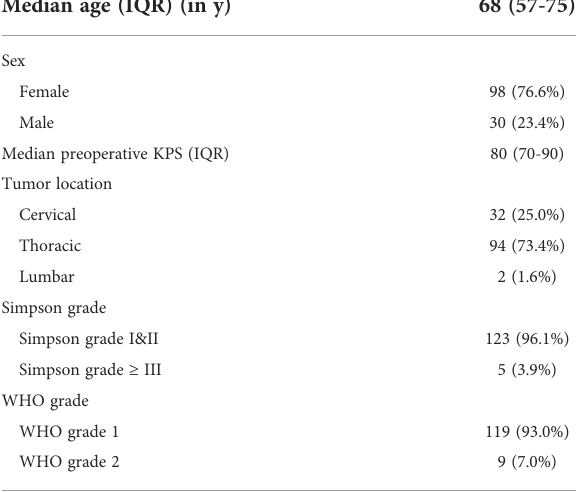
TABLE 1 Patient characteristics (n =